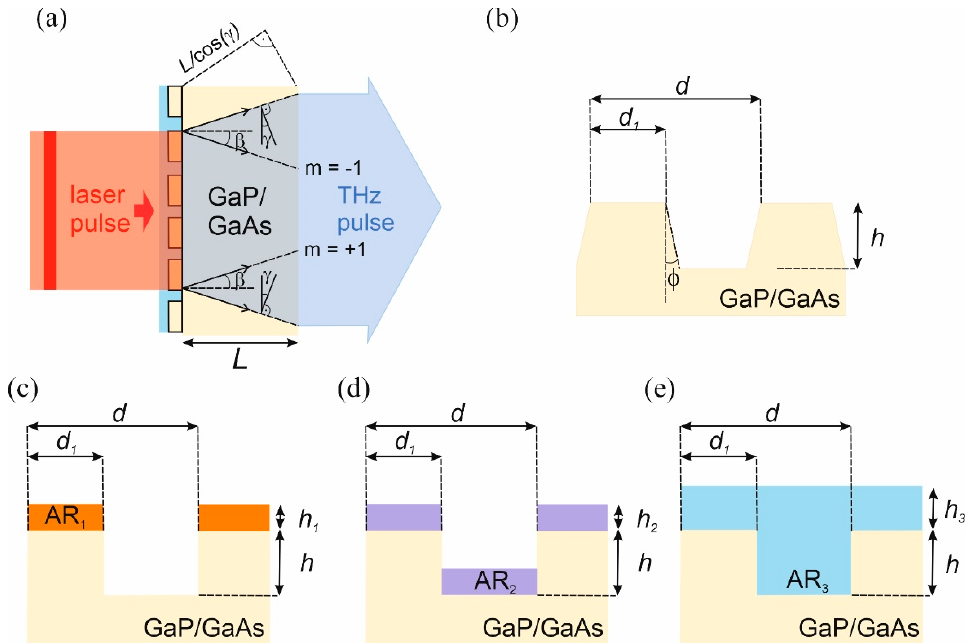
Figure 1. ( a ) Scheme of contact grating THz source. ( b ) Cross-section of a distorted grating profile in- dicating the φ -wall angle. ( c – e ) Rectangular profiles with antireflective (AR) coatings of n AR √ = n AR n GaP / GaAs , and a Norland optical adhesive 170 (NOA), respectively. d —grating pe- riod, d 1 —ridge width, h —groove depth, h 1 — AR 1 thickness, h 2 — AR 2 thickness, h 3 — AR 3 thickness, n GaP / GaAs —refractive index of GaP/GaAs, and L —crystal length.